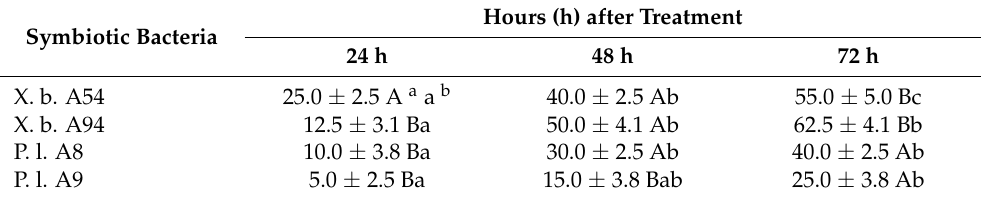
Table 8. The mortality rates (%) of the 5th instar larvae of Cydia pomonella in contact efficacy bioassay of cell-fee supernatants of symbiotic bacteria of the selected entomopathogenic species/isolates. Symbiotic